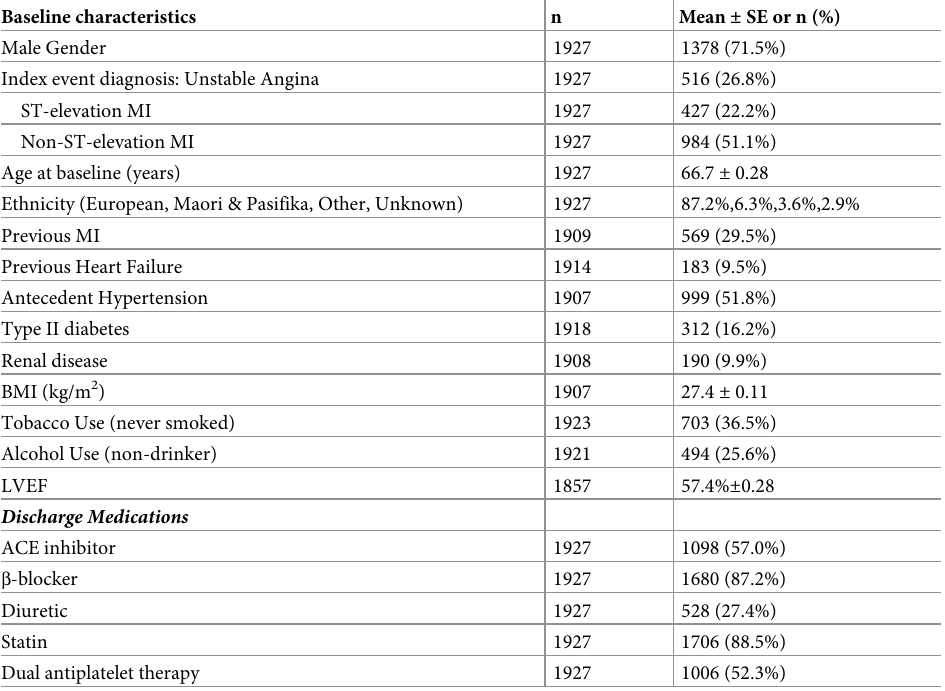
Table 1. Baseline characteristics of the CDCS